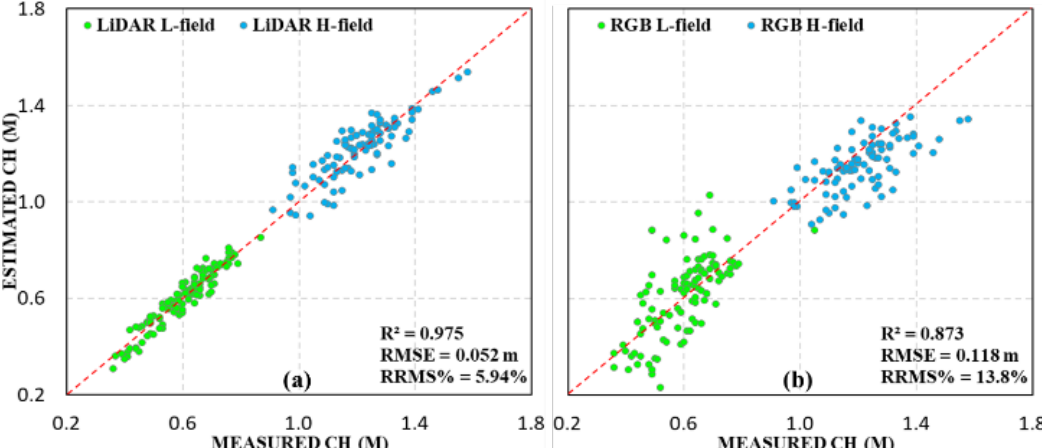
Figure 4. Comparison of field-measured canopy height (CH) with LiDAR and RGB photogrammetry-derived 99 percentiles of canopy height (H99).